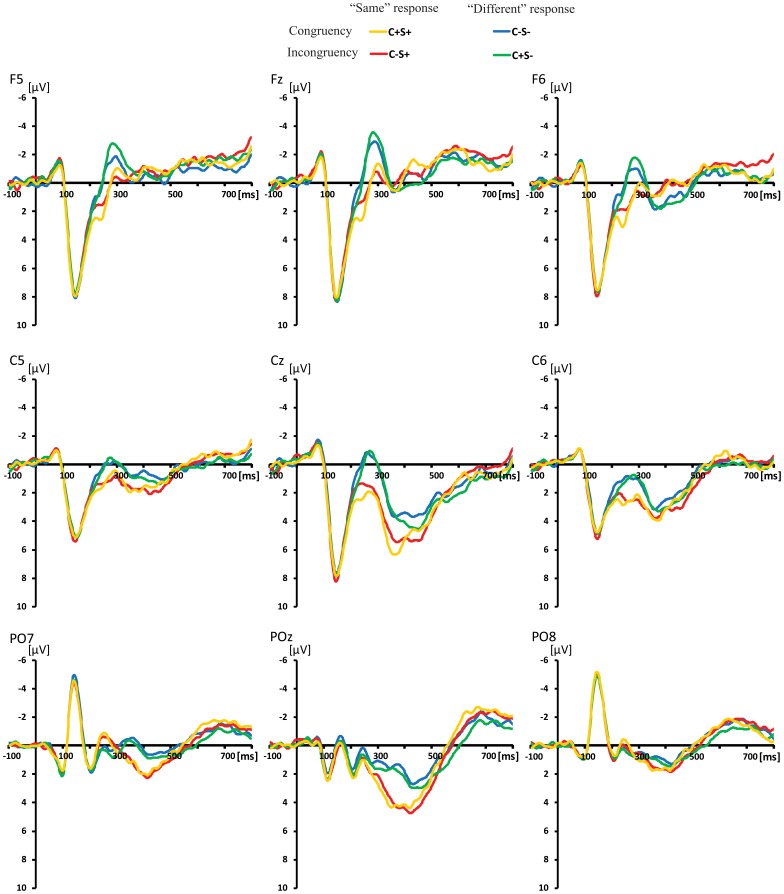
Grand average of the ERP data at the F5, Fz, F6, C5, Cz, C6, PO7, POz, PO8 sites for the C−S−, C−S+, C+S− and C+S+ conditions in the shape task.